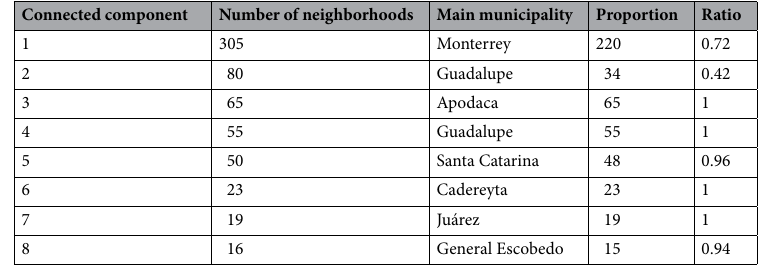
Table 3. Proportion of main municipality within a main connected